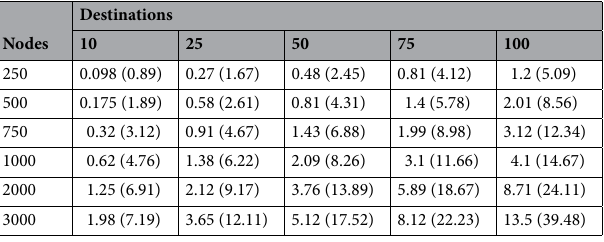
Table 3. Running Time of REMTC and ST (s).